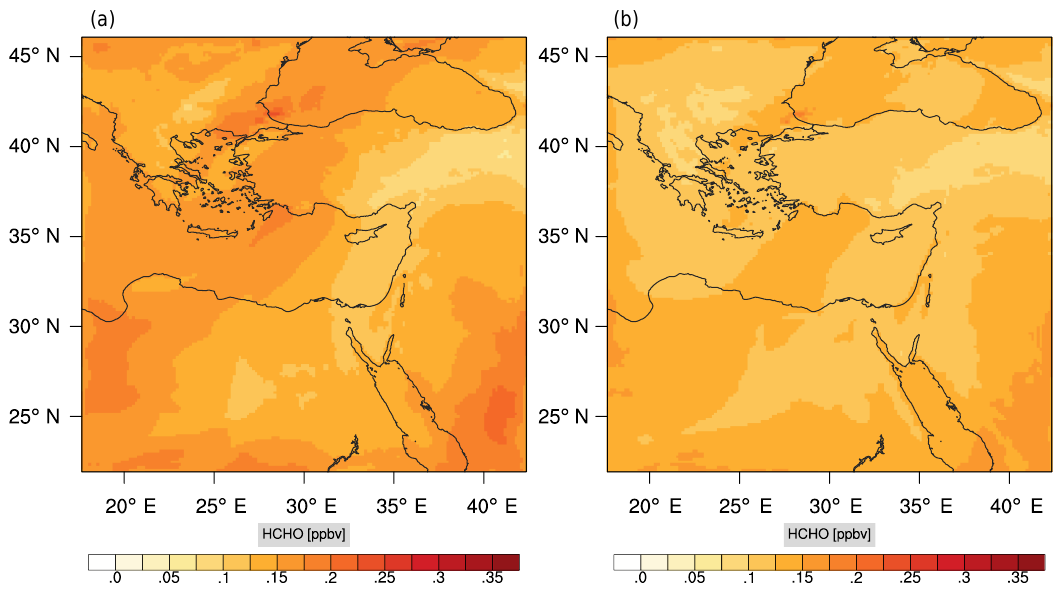
Figure 17. Instantaneous comparison of the formaldehyde spatial mixing ratio, averaged over the vertical layers 10–22, using the full mechanism (a) and skeletal mechanism (b) .